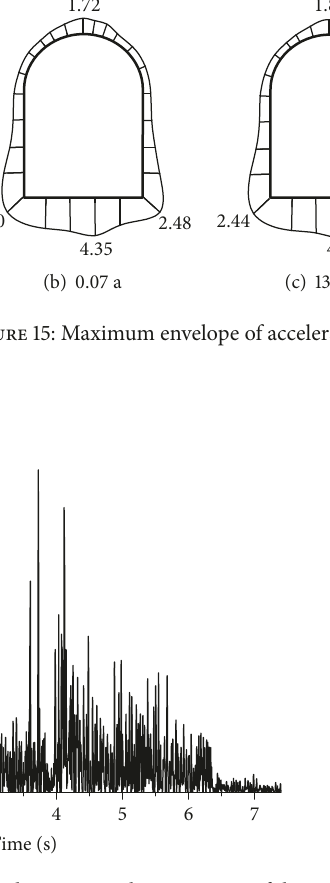
Figure 16: The maximum principal stress time-history curve of the left side wall for the first